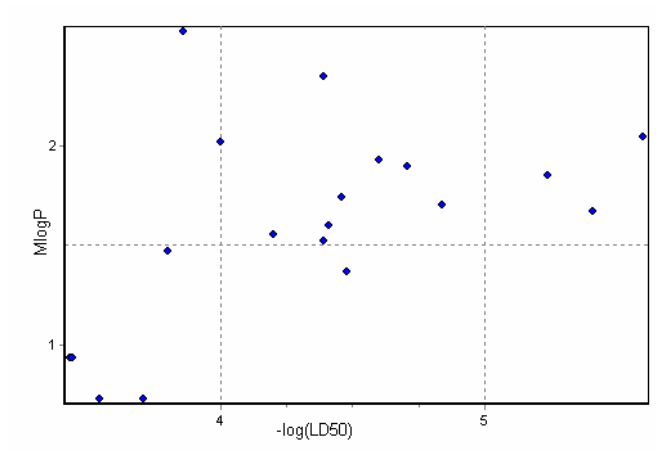
Figure 3. MlogP plotted versus Toxicity